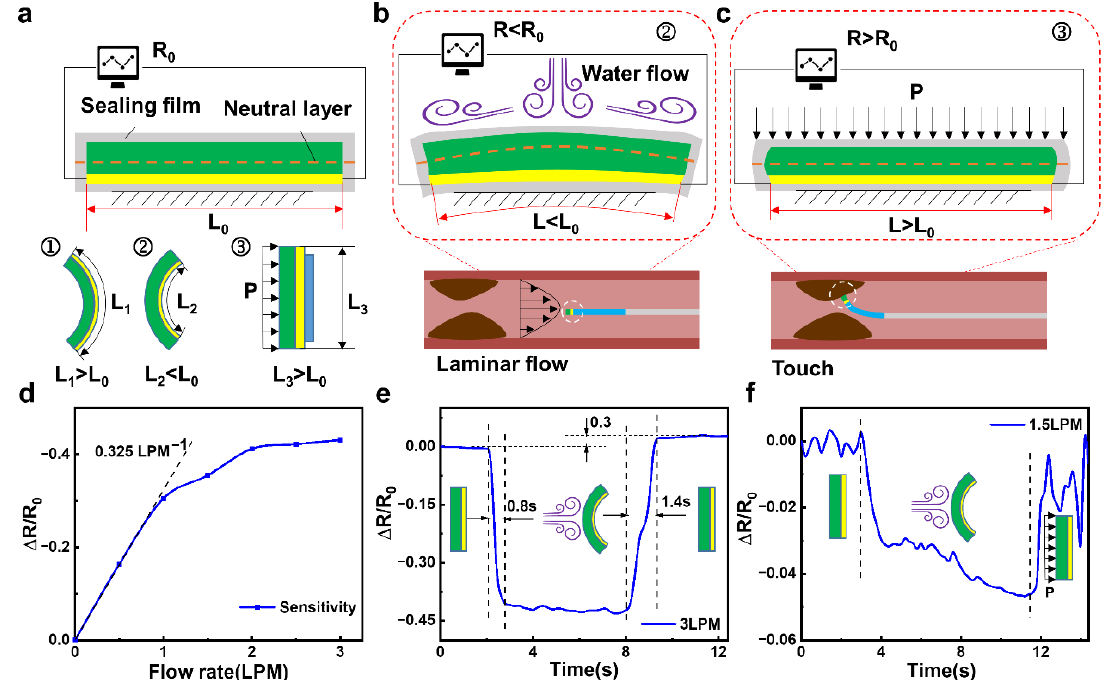
Figure 2. Sensing mechanism and performance of the FIP: ( a ) Deformation sensing mechanism of the FIP, ( b ) Velocity sensing mechanism of the FIP, ( c ) Positioning sensing mechanism of the FIP, ( d ) Sensitivity curve of the FIP, ( e ) Response time curve the FIP, ( f ) Distance sensing curve of the FIP.